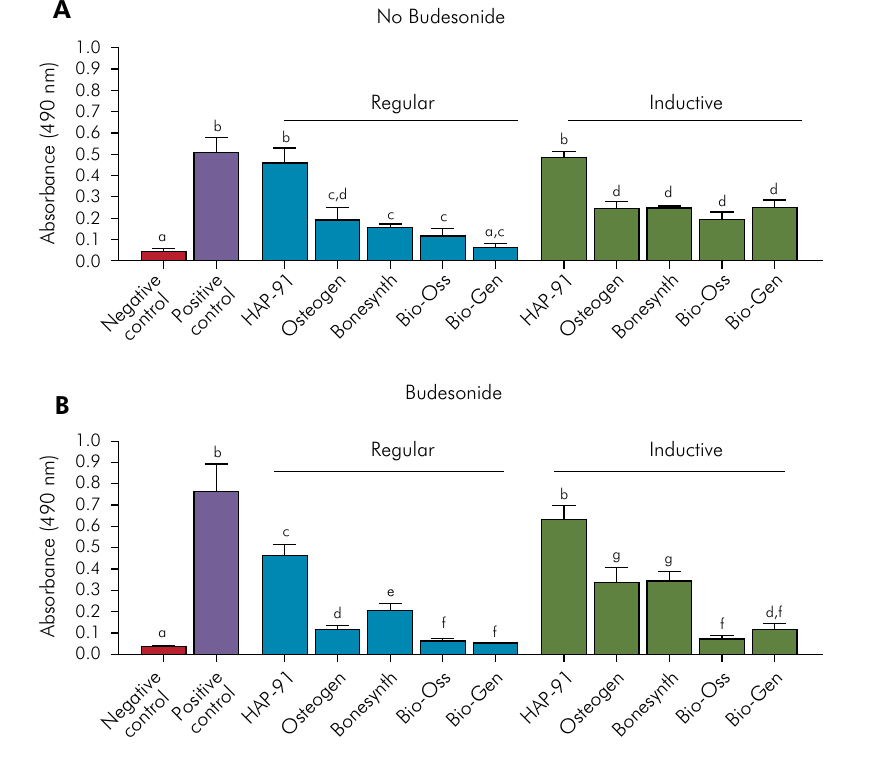
Figure 4. Bar graphs (quantitative AZR S) representing the mineralization potential of MC3T3-E1 cells cultured in media conditioned with each HA comparing the regular and inductive conditions, considering the absence (a) or addition of 0.5% v/v budesonide (b).